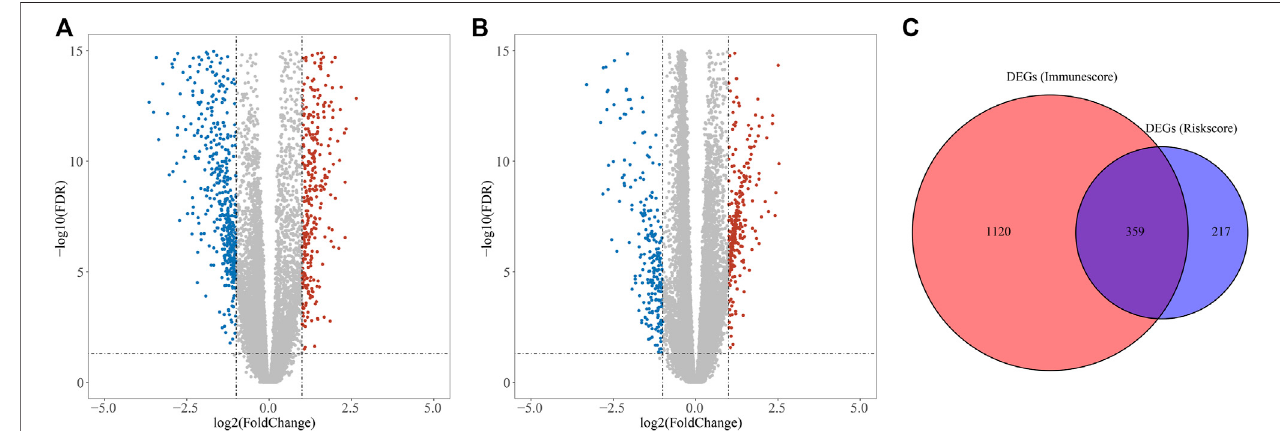
FIGURE 7 | DEGs for functional enrichment and immune activity analysis. (A) Heatmap of DEGs in the high- and low-risk groups. (B) Heatmap of DEGs between high and low levels of immune cell in fi ltration groups. (C) Overlapping genes of these DEGs.